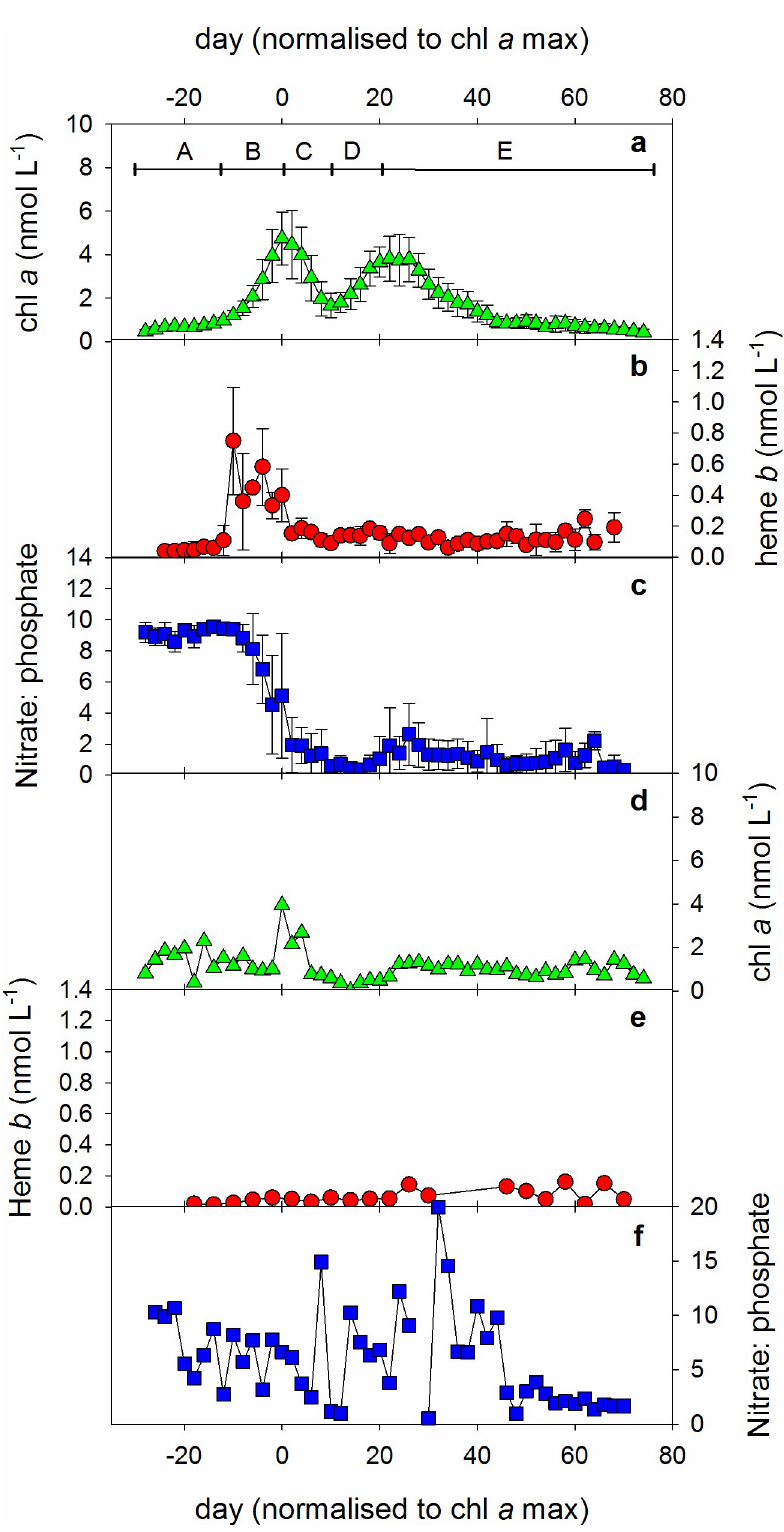
Fig 3. (a) Chlorophyll a concentrations, (b) heme b concentrations and (c) (nitrate + nitrite): phosphate ratio (N:P) in the mesocosms as function of time. Values are expressedas averagesplus or minus the standard deviation. For chlorophyll a and N:P, n = 10, for heme b , n varied between1 and 6, averaging 4.6,